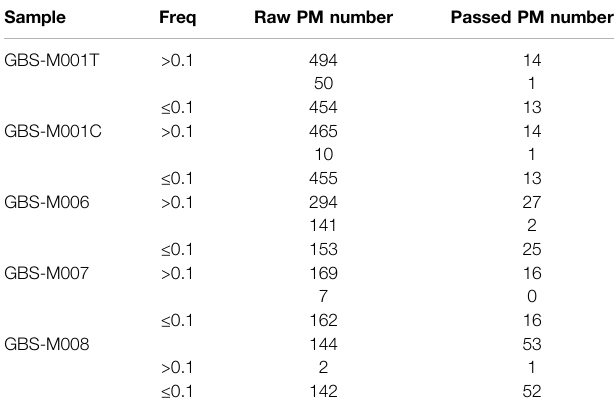
TABLE 1 | PMs found in fi ve GBS samples with